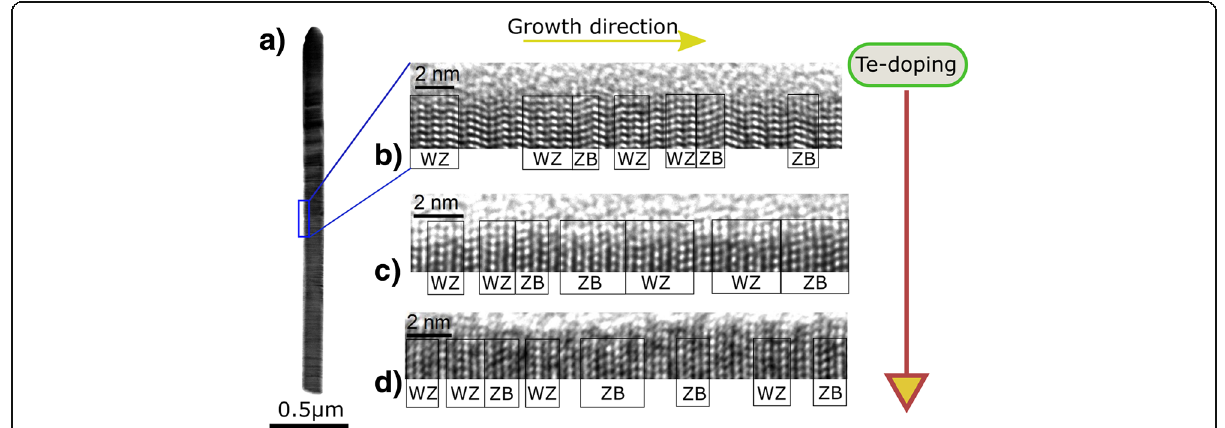
Fig. 3 Te-doping influence on the crystal structure. TEM images depicting the crystal structure in undoped and Te-doped InAs NWs. a Side view of an InAs NW. b – d HR-TEM images of the InAs NW crystal structure (image turned 90° clockwise). The WZ and ZB areas are labeled. The following samples and GaTe-cell temperatures were chosen: b B1 (As 4 -BEP = 2.3 × 10 − 5 Torr), undoped, i.e., 0 °C. c B3 (As 4 -BEP = 2.3 × 10 − 5 Torr),